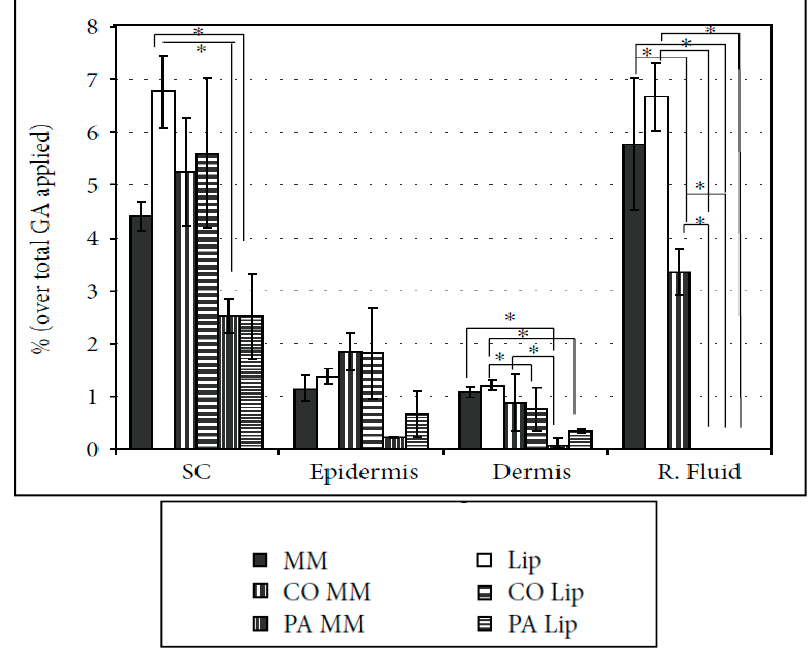
Figure 10. In vitro percutaneous absorption of gallic acid (GA) in liposomes (Lip) and mixed micelle (MM) formulations, and the polyamide (PA) and cotton (CO) cosmeto-textiles (SC: stratum corneum, R. Fluid: receptor fluid) (significant level accepted * p < 0.01).